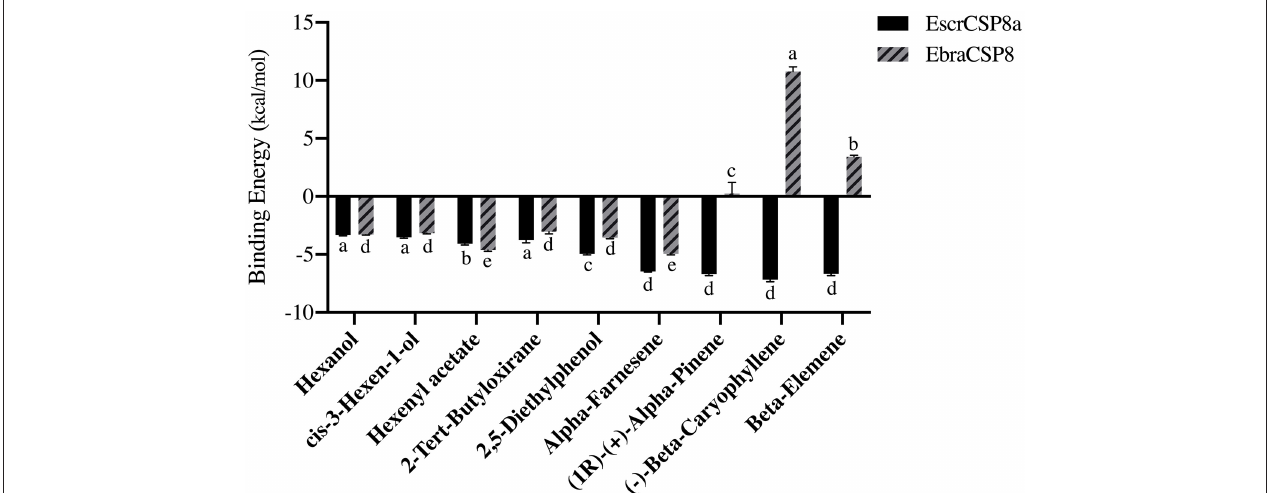
FIGURE 7 | Binding energy of different compounds docking to EbraCSP8 and EscrCSP8a. The bar represents the standard error, and the different small letters (a–e) above each bar indicate significant differences ( P <